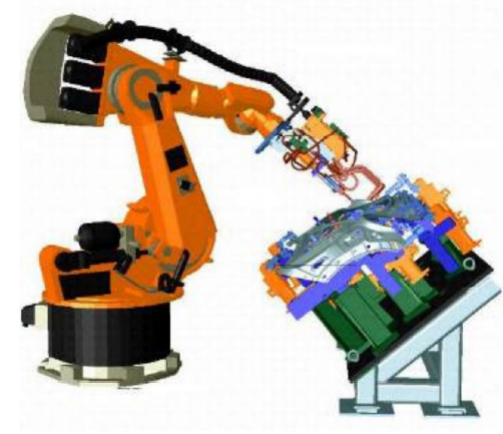
Figure 4. Welding